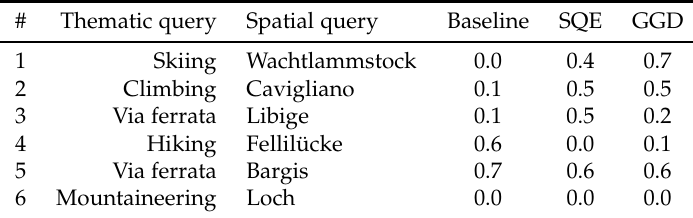
Table 5: Precision values for six individual queries and the three